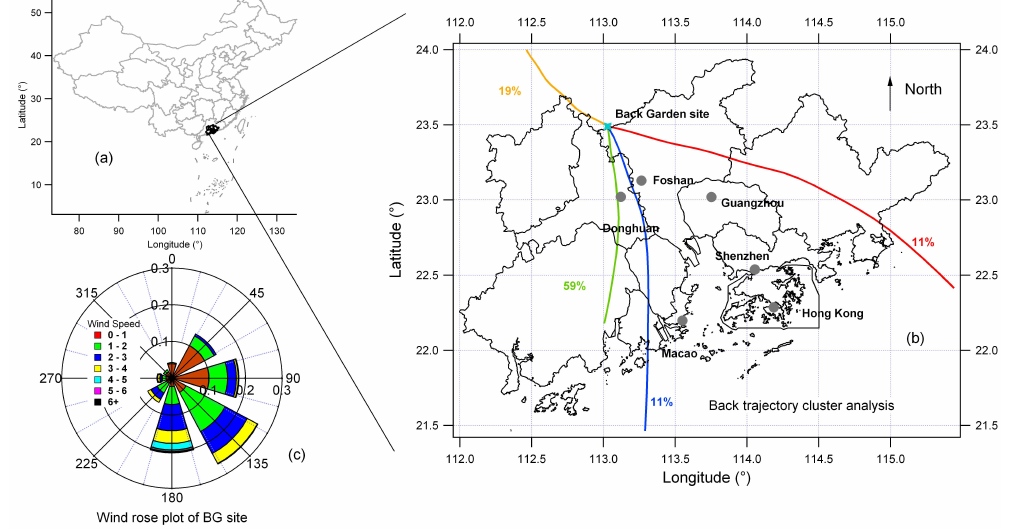
Fig. 1. (a) Map of the PRD area in China. (b) Location of Back Garden site (BG) and major cities related in this study, and also showed the back trajectory cluster analysis results. (c) Wind rose plot of BG site in July